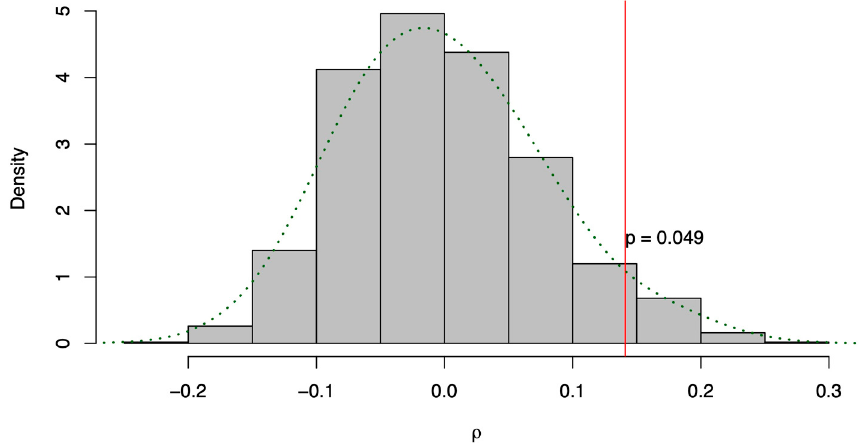
Figure 7. Mantel test histogram showing the correlation ρ between morphometric and SSR genetic distance matrices of 26 A. araucana accessions from the Pistoia nursery industry. The correlation value ( ρ = 0.141) is plotted on the x -axis with p < 0.05 ( p = 0.049) shown by the vertical red line. The green dotted line represents the trend of the